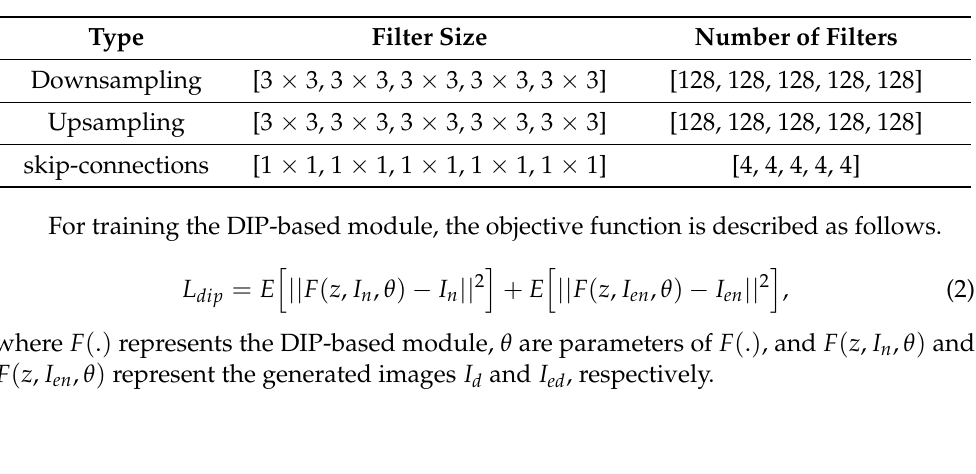
Figure 2. The architecture of the DIP-based module. Note that sc, us, and ds denote skip-connections, upsampling, and downsampling, respectively. Table 1. The detailed architecture of the DIP-based